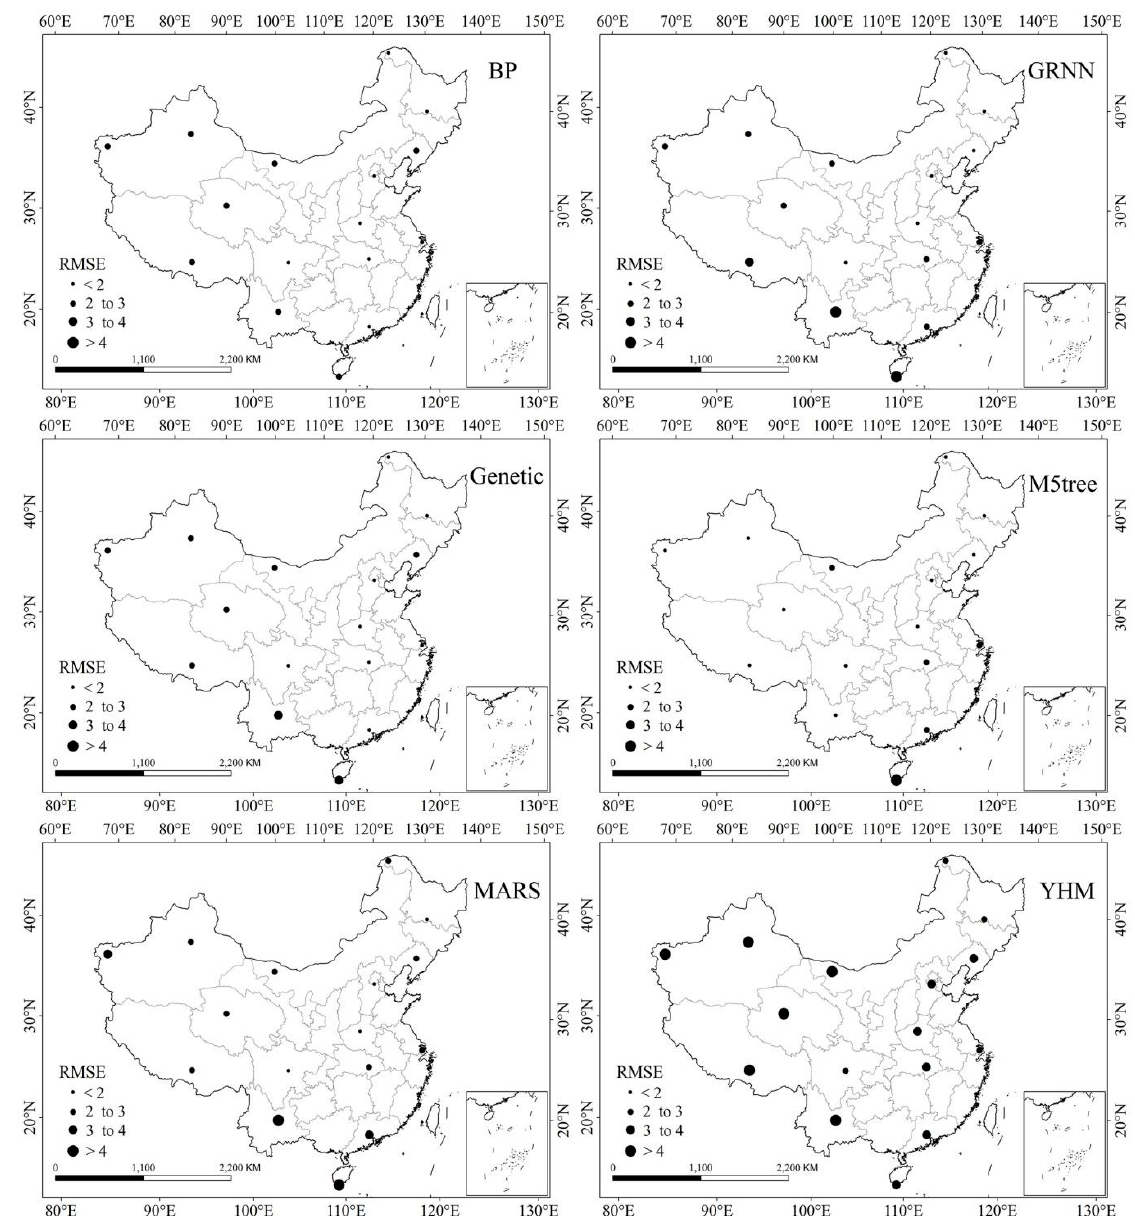
Figure 4. Spatial variation of the root mean square error ( RMSE ) for the six DHI models.